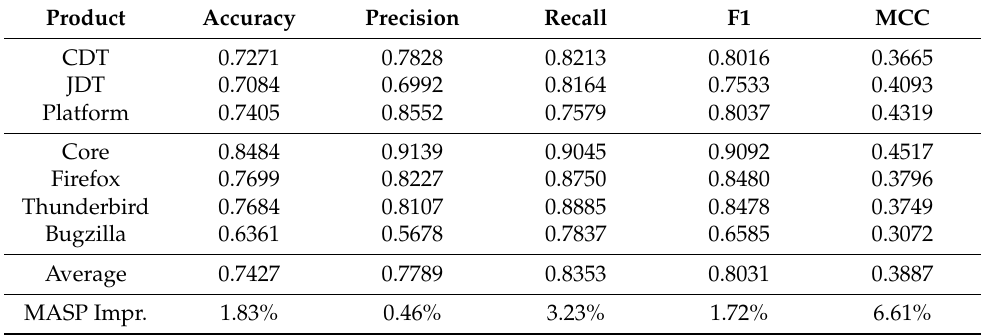
Table 7. Prediction performance of eCNN.